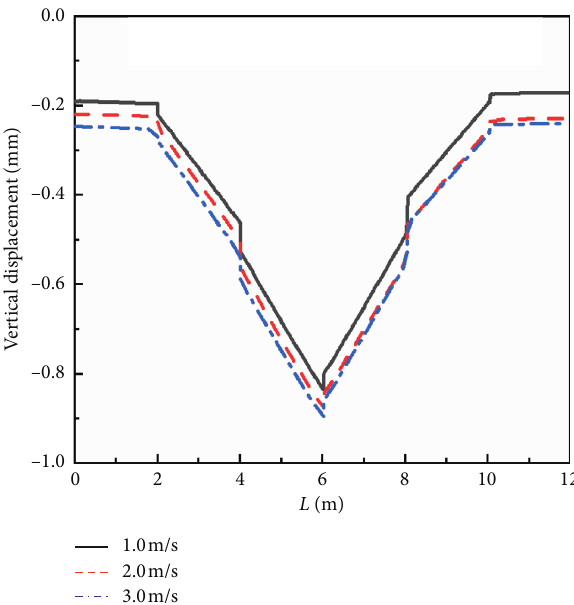
Figure 12: Longitudinal vertical displacement of the crown under different flow